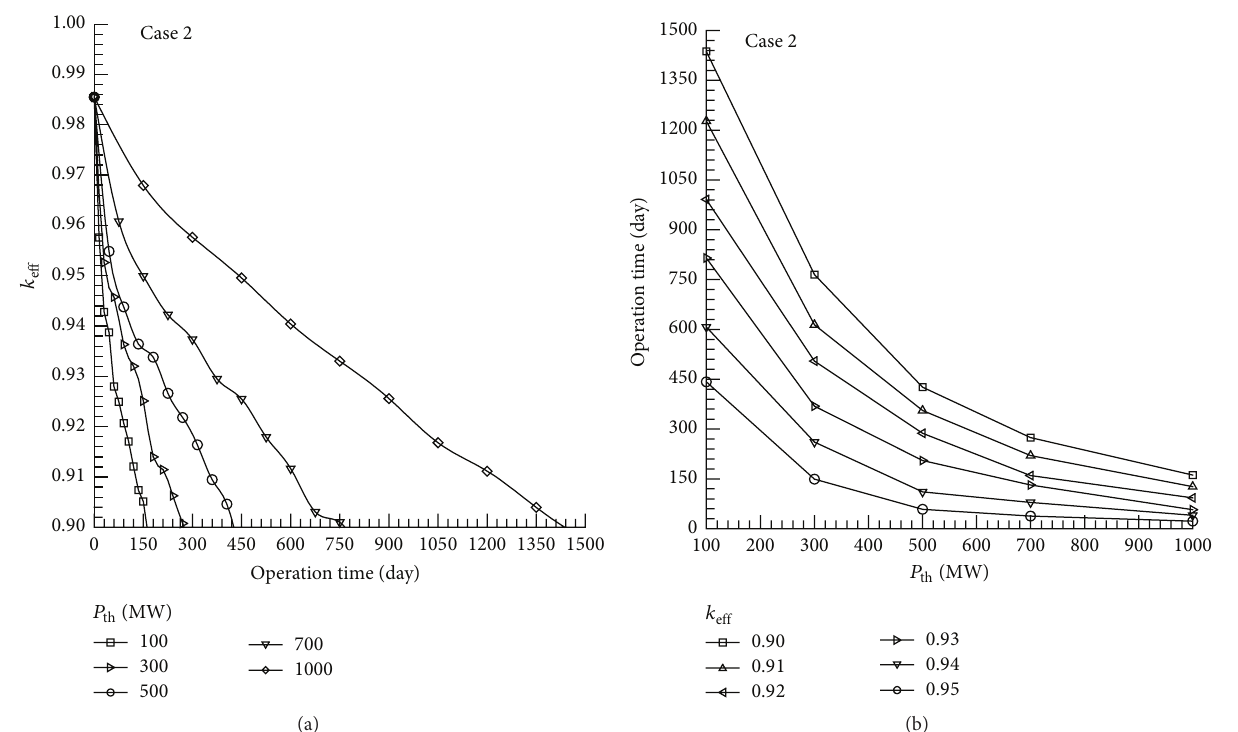
Figure 5: (a) Variations of the effective neutron multiplication in the various cases of thermal power depending on the operation time. (b) The operation time at which effective neutron multiplication reached various values (0.90–0.95) versus the thermal power.